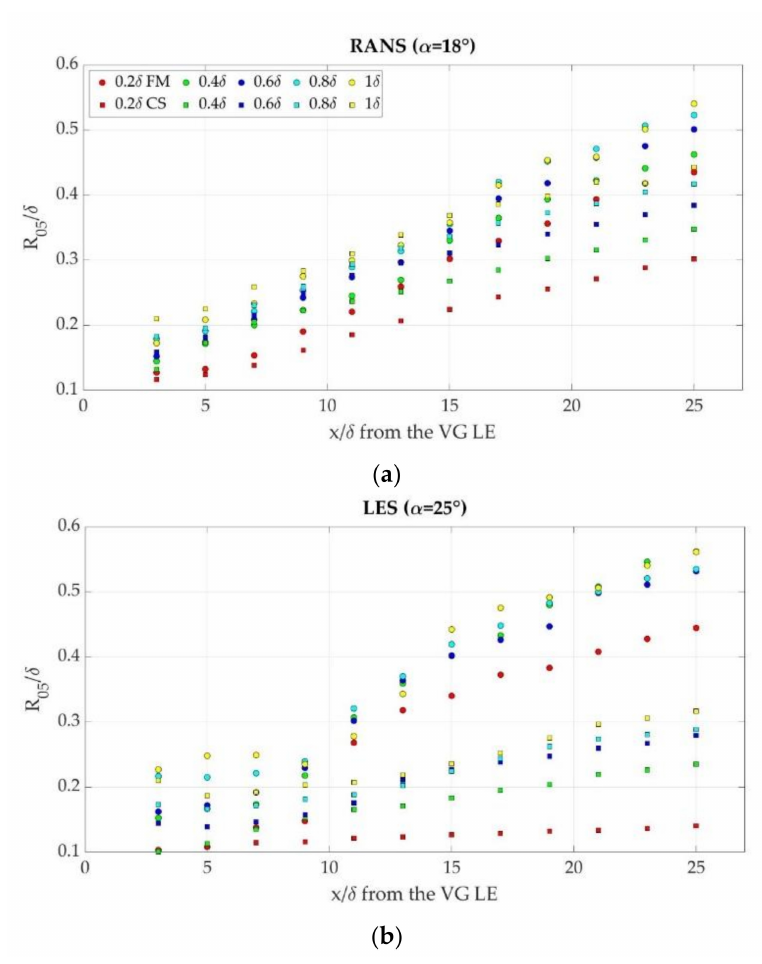
Figure 11. R 05 normalized with δ . ( a ) RANS and ( b )